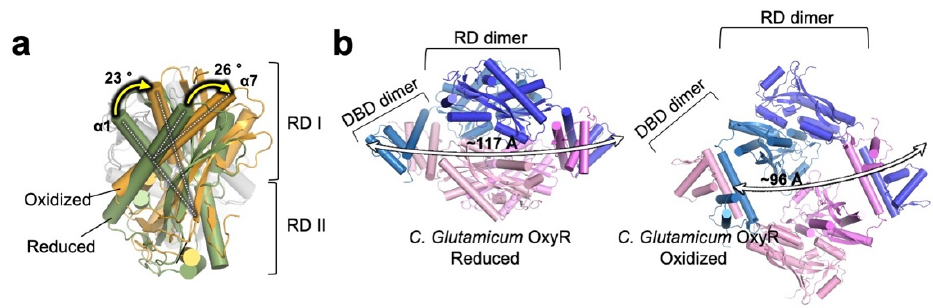
Figure 2. Structural rearrangement of C. glutamicum OxyR upon disulfide bond formation. ( a ) Two regulatory domain (RD) protomers within the dimer in the oxidized form (orange; PDB ID: 6G1B) have a relative rotation of ∼ 30 ◦ , which is not evident in the reduced state (Green; PDB ID: 6G1D). The rotation of α 1 and α 7 of the RD caused by disulfide bond formation is indicated. The subunit that is used as a reference for the superimposition on the backside of the dimer is colored in gray for clarity. ( b ) Reorganization of the tetrameric assembly upon disulfide bond formation. The twist motion in the dimeric interface induces structural rearrangement in the tetrameric assembly, resulting in the shortening of the distances between the DBDs of an RD homodimer (~117 Å in the reduced state (left) and ~96 Å in the oxidized state (right)). Protein Data Bank, PDB.